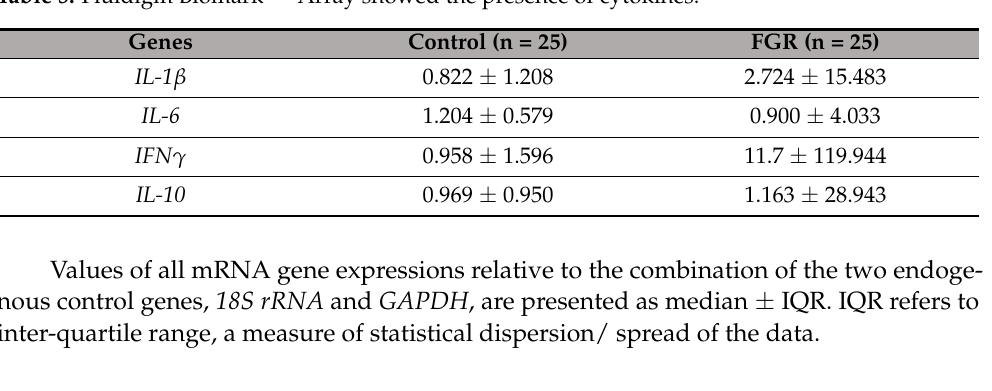
Table 5. Fluidigm Biomark TM Array showed the presence of cytokines.